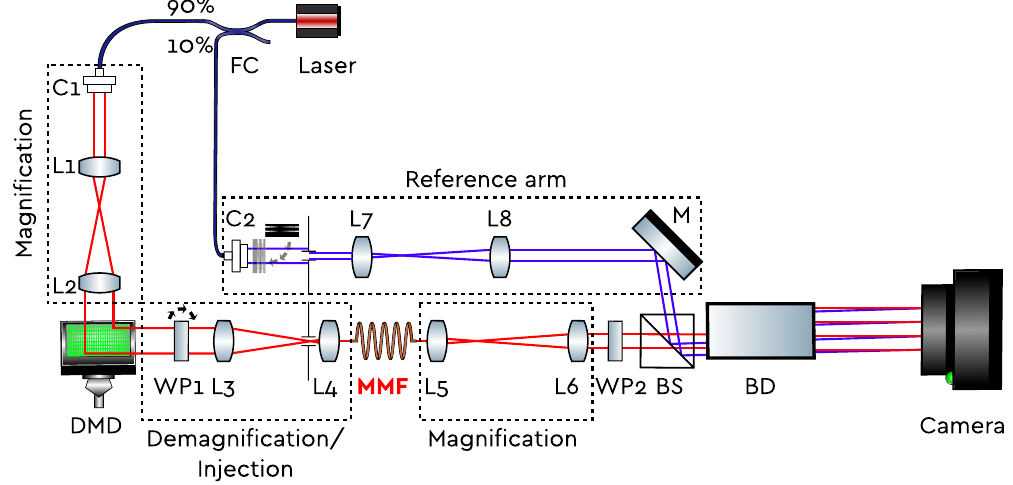
FIG. 5. Experimental setup. L